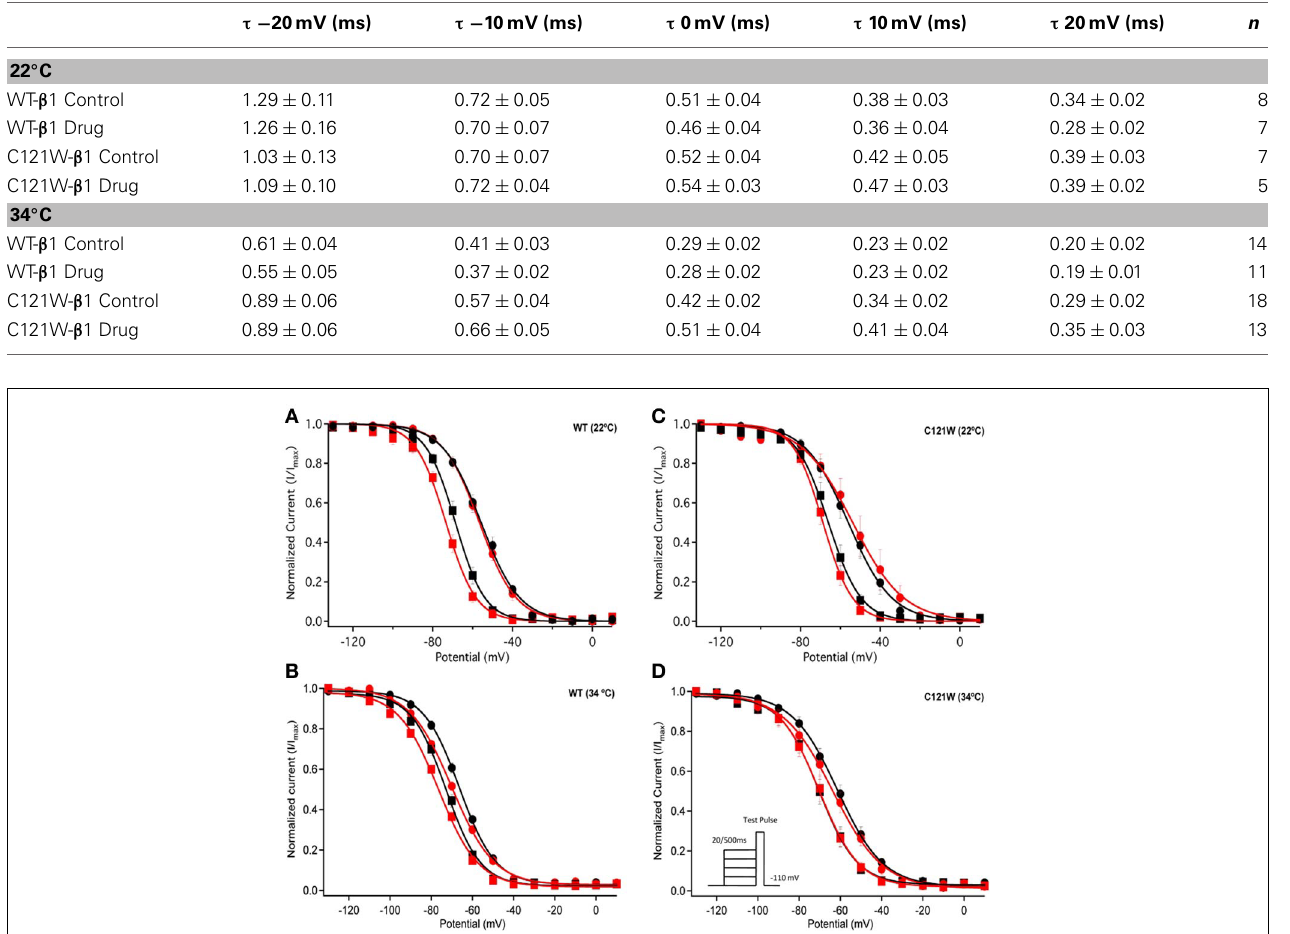
and C121W at 22 ◦ C and 34 ◦ C (C,D) . The means of control (shown in black) were compared to 100 μ M Lacosamide (shown in red). In panel (D) , an inset shows the pulse protocol used to measure steady-state fast